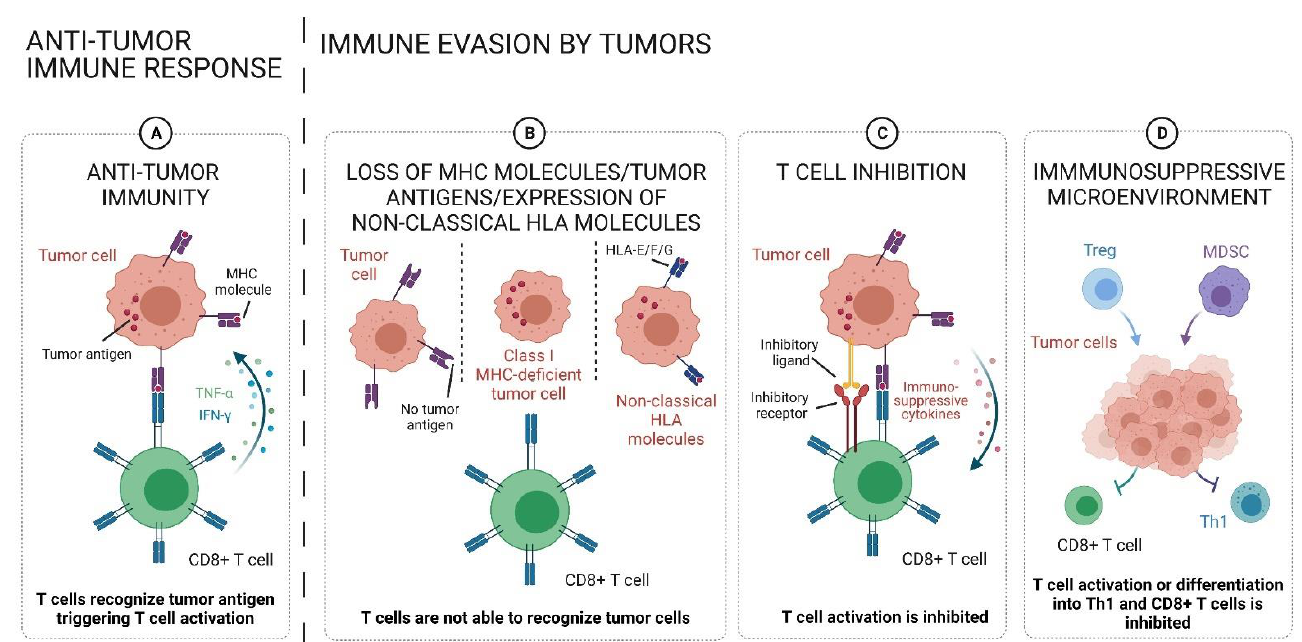
Figure 1. Overview of immune response to tumor vs. immune evasion mechanisms by tumors in context of CD8+ T cells. ( A ) CD8+ T cells are the preferred immune cells in the role of immunity against targeting cancer through their capacity to kill malignant tumor cells upon the recognition by T cell receptor (TCR) of specific tumor antigens presented on the surface of major histocompatibility complex (MHC) molecules. ( B ) MHC class I molecules can be downregulated on tumor cells and CD8+ T cells are not able to recognize tumor cells. Furthermore, the loss-antigen variant of tumor cells leads to lack of tumor recognition by CD8+ T cells. ( C ) T cell responses are inhibited by the involvement of inhibitory receptors and their corresponding ligands. Immunosuppressive cytokines lead to suppression of the anti-tumor immune response. ( D ) Regulatory T cells (Tregs) suppress the T cell responses to tumors. Myeloid-derived suppressor cells (MDCSs) accumulate and suppress anti-tumor T cell responses. Created with BioRender.com.